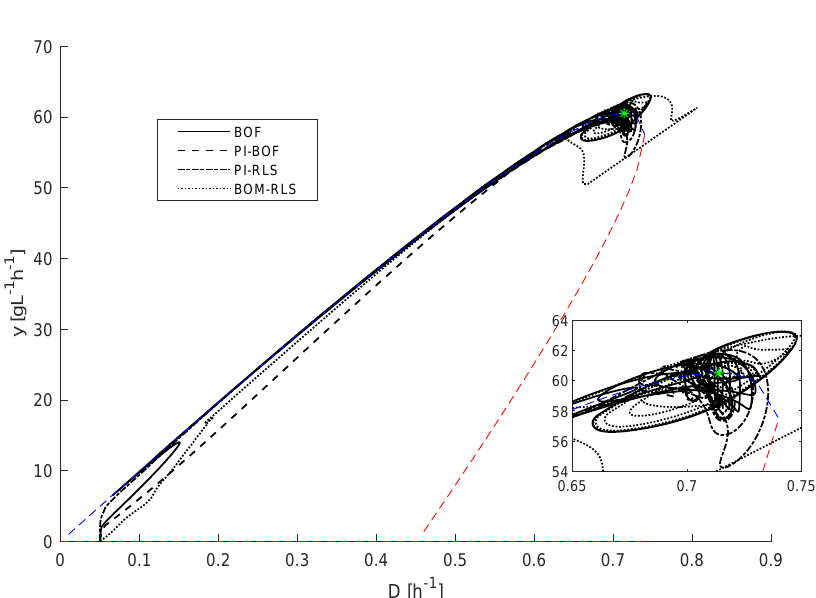
Figure 11. Application of the BOF, PI-BOF, PI-RLS, and BOM extremum seeking methods to optimize biomass productivity of microbial growth represented by model (3) with Haldane kinetics—convergence diagram.